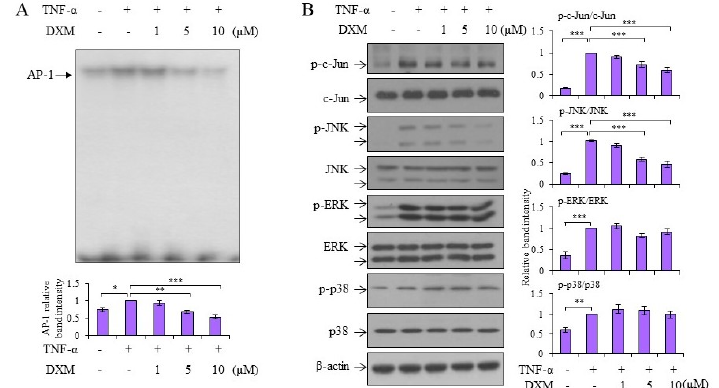
Figure 4. DXM inhibited TNF- α -induced activator protein-1 (AP-1) DNA binding activity through modulating c-Jun activation. ( A ) Porcine chondrocytes were treated with TNF- α (5 ng/mL) and various doses of DXM for 4 h and nuclear lysates were collected to determine the DNA-binding activity of AP-1 by EMSA. ( B ) Porcine chondrocytes were pretreated without or with various doses of DXM for 2 h, and then stimulated with TNF- α for 15 min. Total cell lysates were analyzed by Western blots. The results showed representative data from a pool of at least three independent experiments from different donors, and the data are shown as fold induction compared to the TNF- α -stimulated sample. Values are the means ± S.E.M. and significance (* p < 0.05; ** p < 0.01; *** p < 0.001) was analyzed by one-way ANOVA.